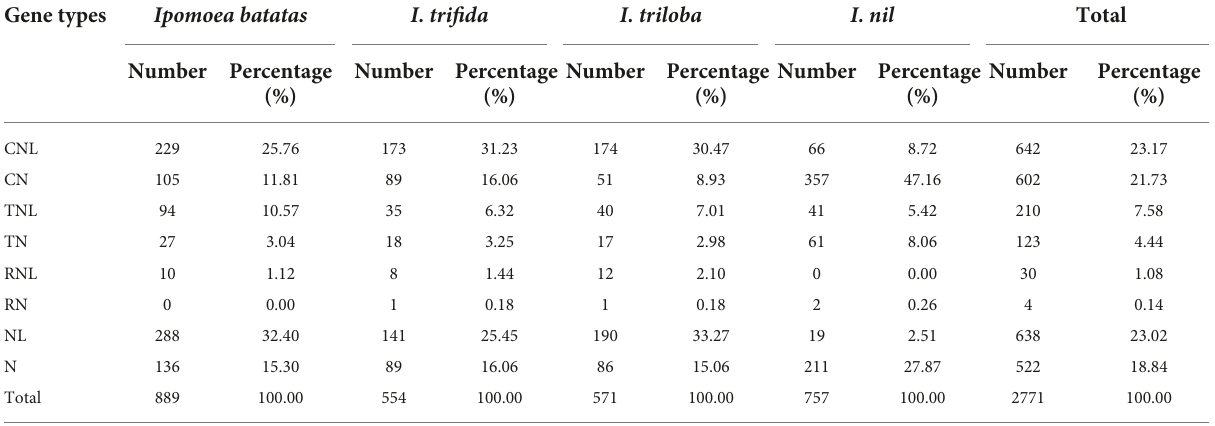
TABLE 1 Classification and distribution of nucleotide-binding site (NBS)-encoding genes in the four Ipomoea genomes. Gene